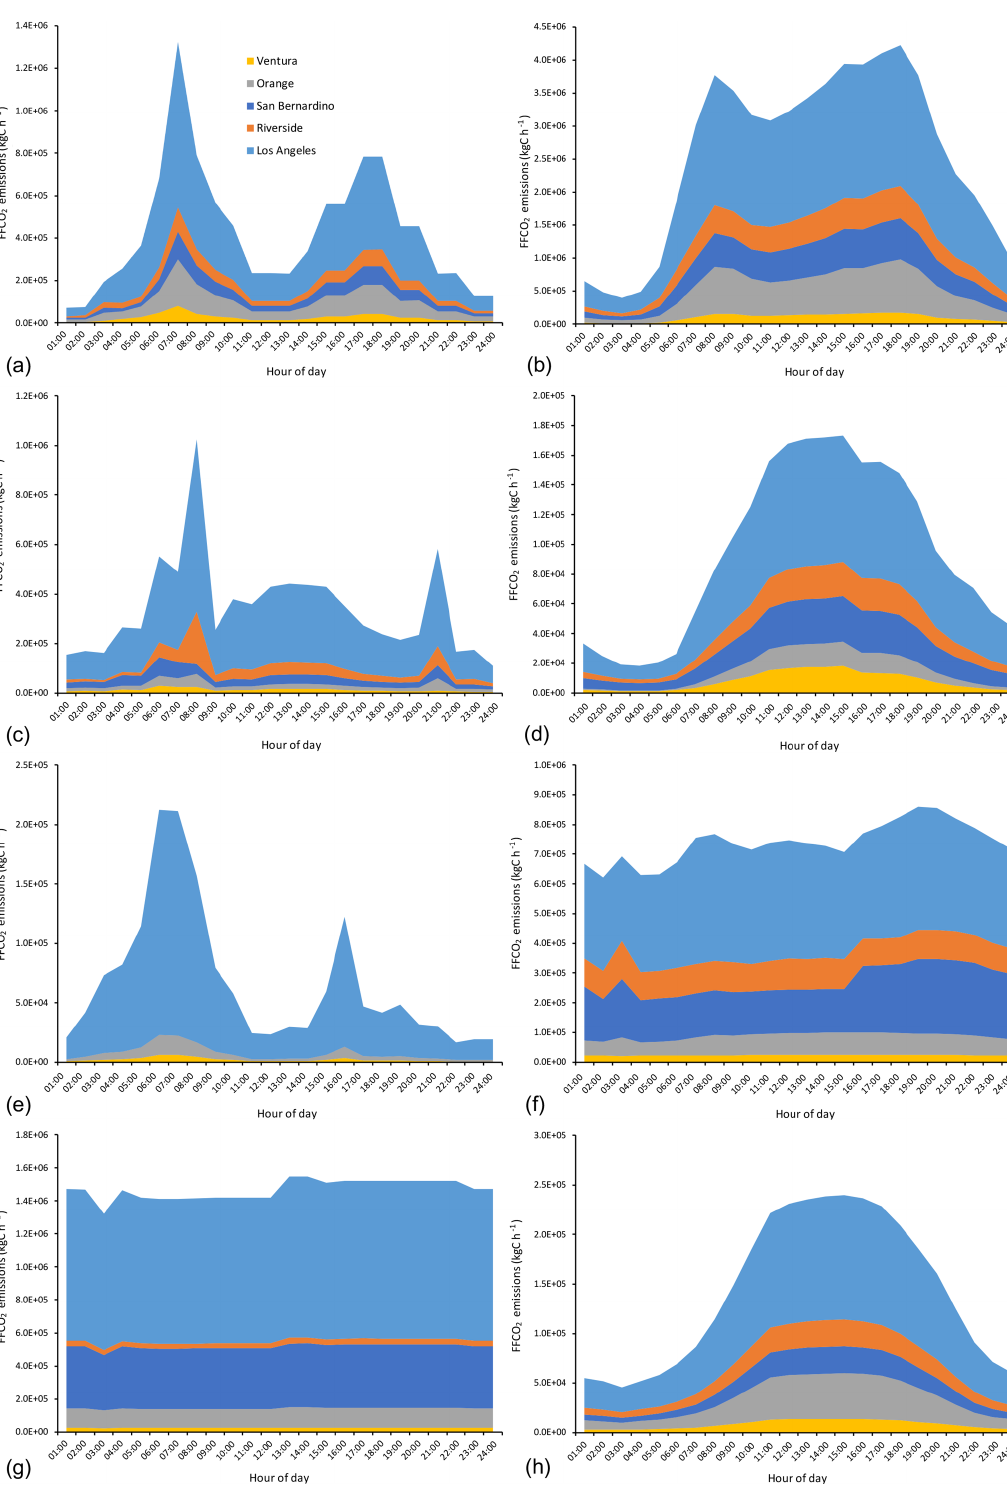
Figure 15. Average daily FFCO 2 emissions in the Hestia-LA v2.5 data product for five counties across eight sectors: (a) residential, (b) on- road, (c) commercial, (d) airport, (e) commercial marine vessel, (f) electricity production, (g) industrial, and (h) non-road. Note the different scale ranges on each plot. Units: kgCh − 1